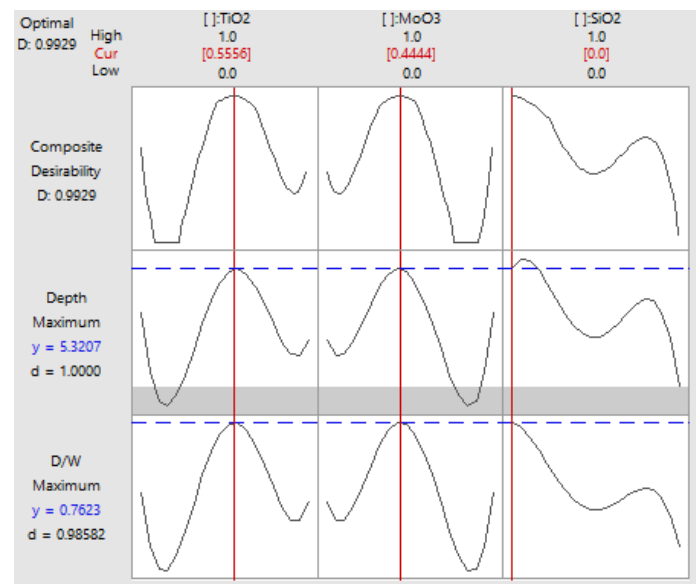
Figure 8. The optimization plot for depth and ratio D / W.